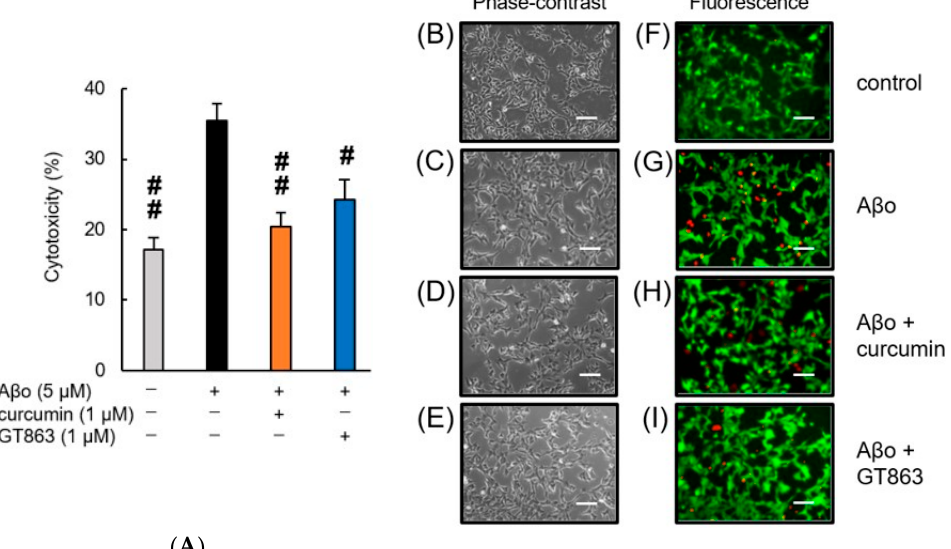
Figure 4. Effect of curcumin and GT863 on the cytotoxicity in A β o-stimulated SH-SY5Y cells. The cytotoxicity in A β o-stimulated SH-SY5Y cells was evaluated using EthD-1 cell assay. ( A ) The cytotoxicity of SH-SY5Y cells exposed to 5 µ M A β o and treated with A β o + 1 µ M curcumin, A β o + 1 µ M GT863. +: inclusion of 5 µ M A β o, curcumin, GT863; − : non-inclusion. The p -values in ANOVA were < 0.001. Each value expresses the mean + S.E.M. of at least 3 independent experiments. In the absence of 5 µ M A β o, the cytotoxicity of control, 1 µ M curcumin-treated, 1 µ M GT863-treated cells were 17.15 ± 1.67, 19.23 ± 1.74, and 19.11 ± 1.41%, respectively (no significant difference, n =